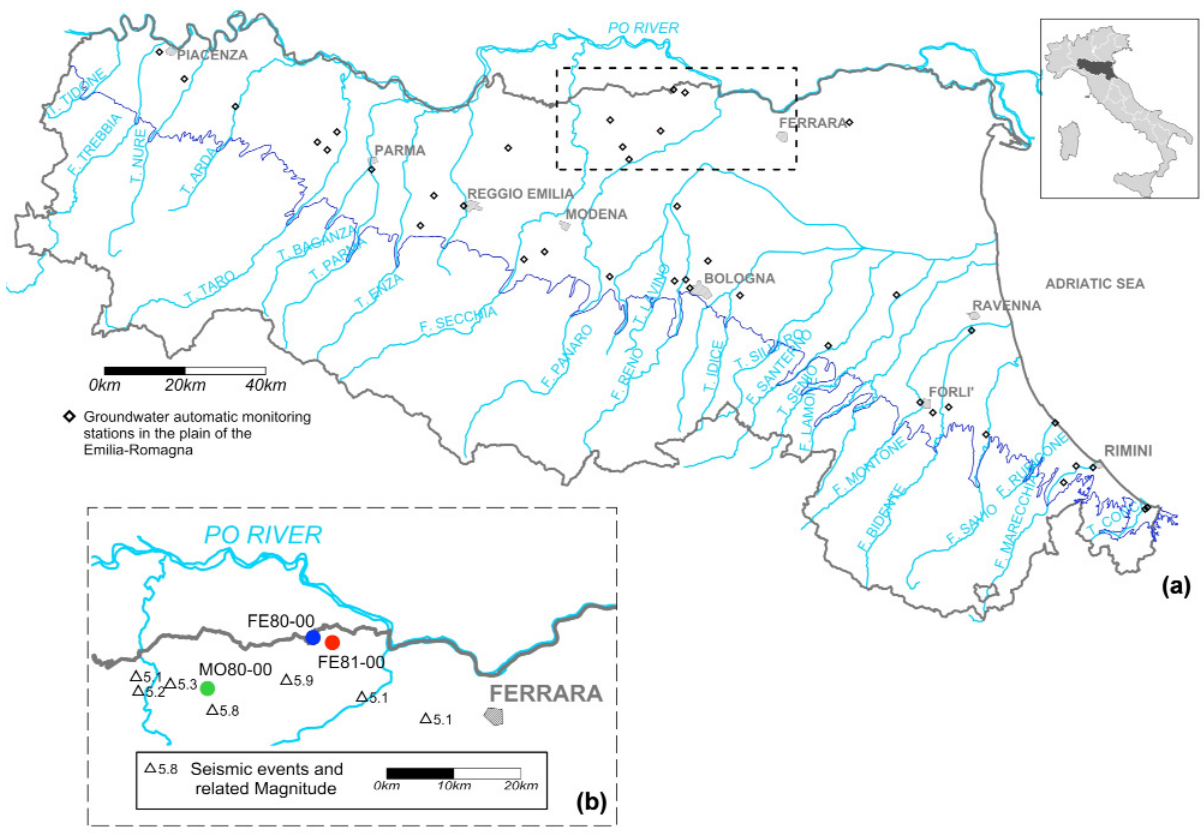
Figure 1. (a) Geographical sketch of the Emilia-Romagna region showing all of the groundwater automatic monitoring stations managed by ARPA Emilia-Romagna. (b) Monitoring stations considered and epicenters of the most relevant seismic events, as characterized by 5.1 ≤ M ≤ 5.9 [INGV 2012].